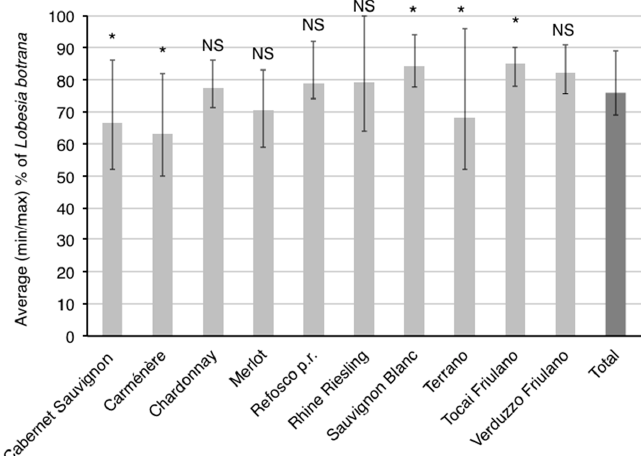
Figure 2. Proportion of Lobesia botrana larvae on the total of both moth species calculated for each cultivar and all the cultivars together (Total). Eupoecilia ambiguella % = 100% − L. botrana %. NS and * indicate, respectively, not significant and significant differences at the 0.05 level between each cultivar and Total, according to a Cochran’s Q -test.